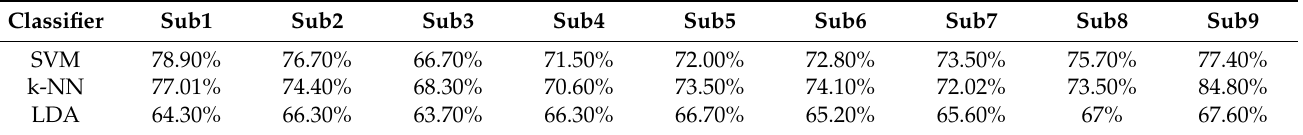
Table 1. Accuracy of conventional machine-learning (ML) algorithms, k-nearest neighbor